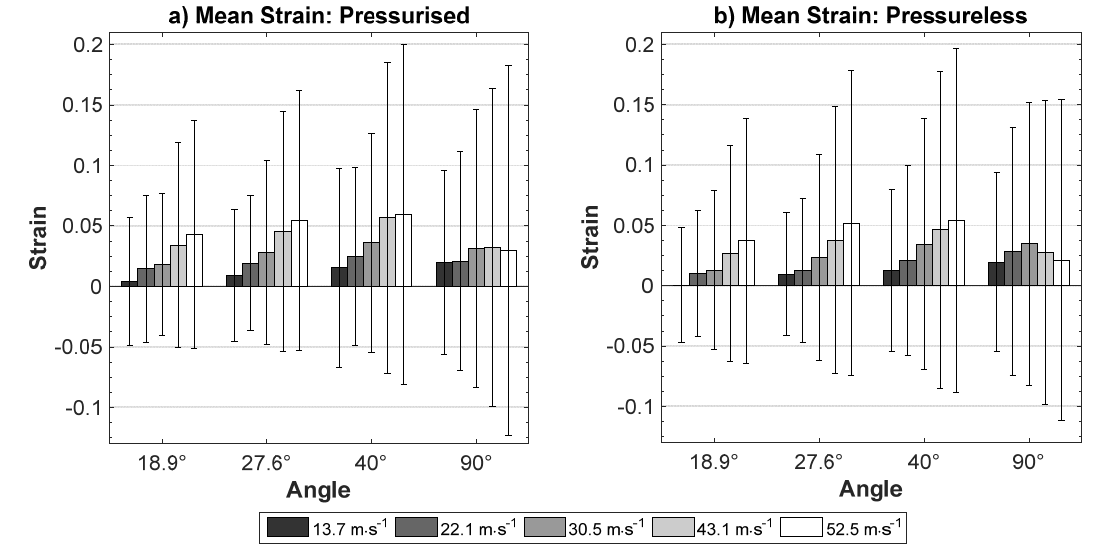
Figure 7. Mean strain during impact for pressurised ( a ) and pressureless ( b ) ball cores.